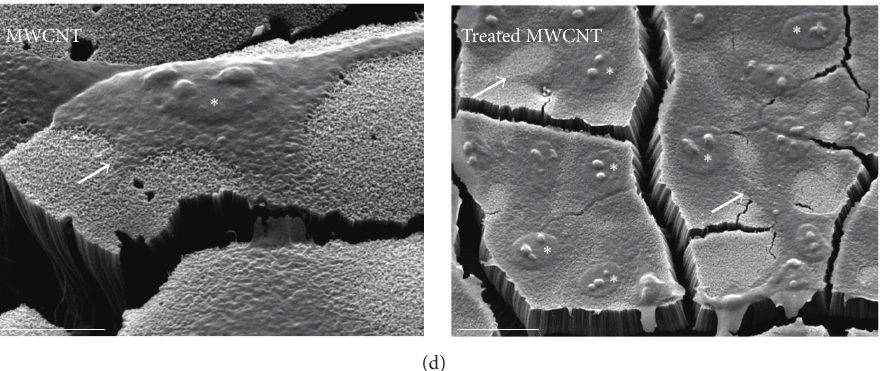
Figure 6: Growth characteristics of R28 cells after cultivation on plasma-treated MWCNT structures. (a) Analysis of cell viability in cultures incubated for 24 hours with increasing serial dilutions of extractive media obtained from nonfunctionalized and plasma-treated MWCNT- Fe-Pt wafer slices and certified RM A, RM B, and RM C ( 𝑛 = 4 individual experiments). Extractive medium without the incubation of any material (glass) was used as internal negative control; its mean values are marked by the dotted lines. Data are represented as mean ± SD. They were compared to the glass control and analyzed using unpaired two-tailed 𝑡 test. ∗∗∗∗ 𝑃 < 0.0001 , RM A (1:1) and RM B (1:1); ∗ 𝑃 = 0.0319 , treated MWCNT (1: 1); ∗∗ 𝑃 = 0.0037 , RM A (1:2); ∗∗ 𝑃 = 0.0047 , RM A (1:4). (b) Effects of direct contact on viability of cells grown on glass and on nonfunctionalized and plasma-treated MWCNT-Fe-Pt wafer slices ( 𝑛 = 3 individual experiments). Cells were stained using FDA/PI and counted 72 hours after seeding. For each substrate, 12 randomly selected microscopic fields were analyzed. Data are represented as mean ± SD. The total cell numbers were normalized and compared to the glass control and analyzed using unpaired two-tailed 𝑡 test ( ∗∗ 𝑃 = 0.0048 , treated MWCNT). The quantity of dead cells is shown as a percentage of the corresponding total cell number. They were compared to the treated MWCNT probe and analyzed using unpaired two-tailed 𝑡 test ( ∗∗∗ 𝑃 = 0.0007 , glass; ∗∗ 𝑃 = 0.0016 , MWCNT). (c) qRT-PCR was used to analyze the expression of different genes representing neuronal/glial and retinal markers or involved in the cell cycle ( 𝑛 = 3 individual experiments). Using the comparative CT ( 2 −ΔΔ CT ) method, the relative gene expression ratio of cells cultivated on nonfunctionalized MWCNTwas set to 1. For plasma-treated MWCNT, values > 1denote an upregulated and values < 1denote a downregulated gene expression. Each column represents the median, maximum, minimum, and the 50th percentile of the data. Data were analyzed using one sample two-tailed 𝑡 test, showing no significant differences. (d) Scanning electron microscopy images of R28 cells plated on nonfunctionalized (scale bar: 10 𝜇 m) and plasma-treated (scale bar: 20 𝜇 m) MWCNT-Fe-Pt silicon wafers. Cultivation was terminated 72 hours after seeding. Arrows indicate cell adhesion and individual cell nuclei are marked with stars. Note that the cracks within the MWCNT structures were due to the fixation and drying